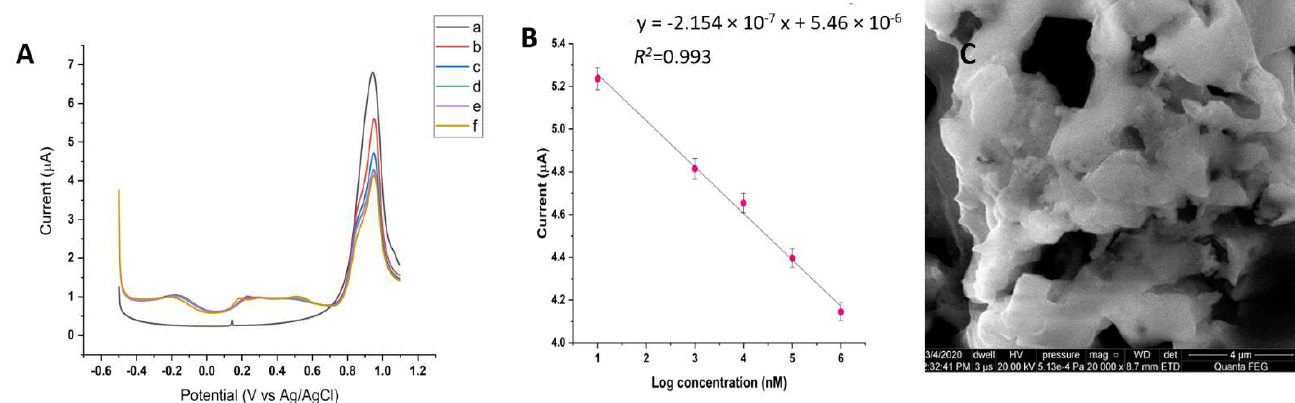
Figure 4. ( A ) DPV of the chemosensor in the presence of ACR. The ACR concentration (a–f) was used as follows: (a) Control (b) 1 × 10 − 8 M, (c) 1 × 10 − 6 M, (d) 1 × 10 − 5 M, (e) 1 × 10 − 4 M, (f) 1 × 10 − 3 M; ( B ) The calibration curve of standard ACR with R 2 = 0.993. ( C ) A representative SEM micrograph of the chemosensor surface after its exposure to ACR with an estimated surface roughness of 0.24 µ